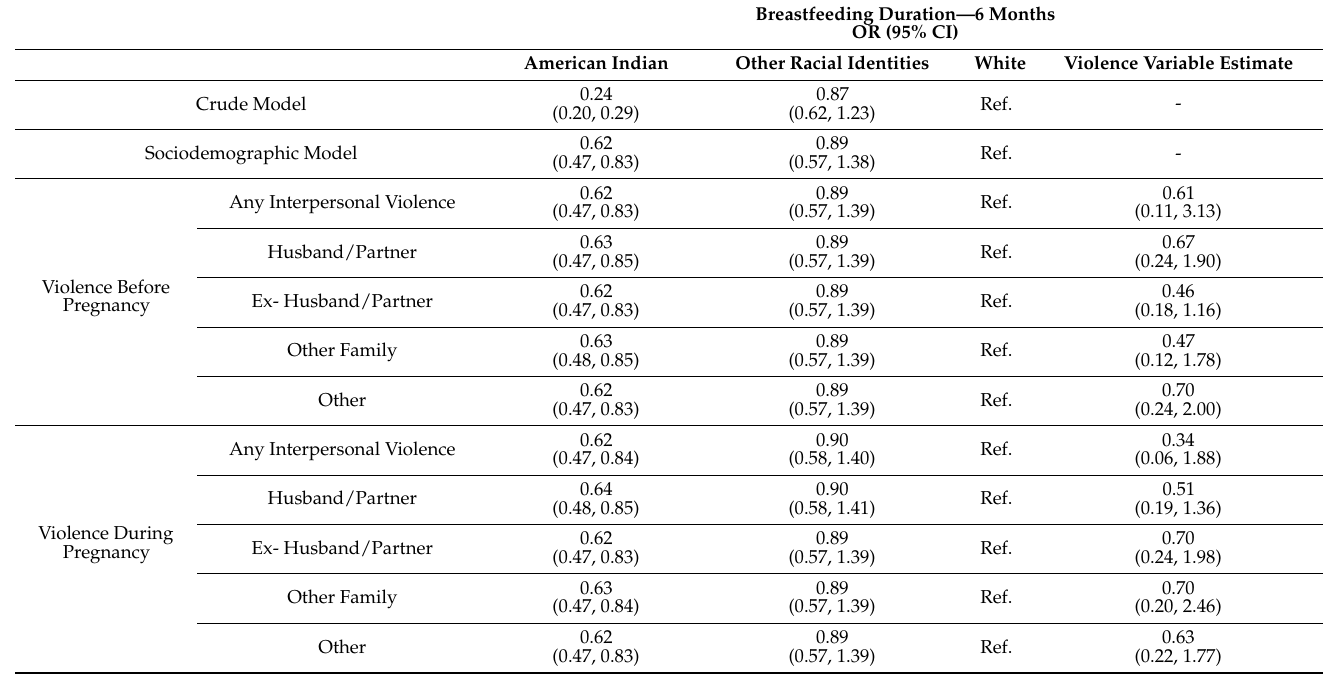
Table 5. Association between race/ethnicity and breastfeeding for at least six months, adjusted for violence exposure before and during pregnancy 1